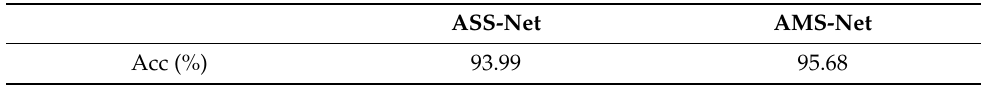
Table 8. Accuracy results (%) of ASS-Net vs.